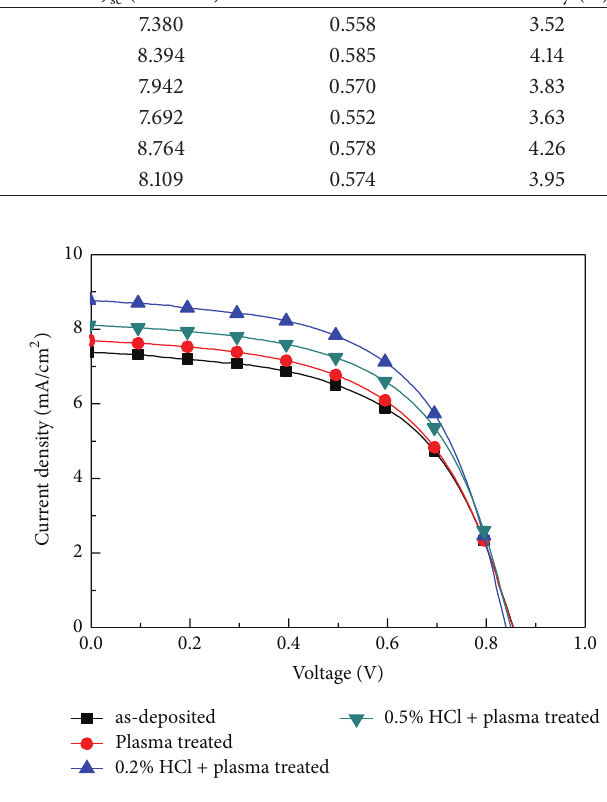
Figure 8: Current-voltage characteristics of the p-i-n 𝛼 -Si:H thin film solar cells under illumination.